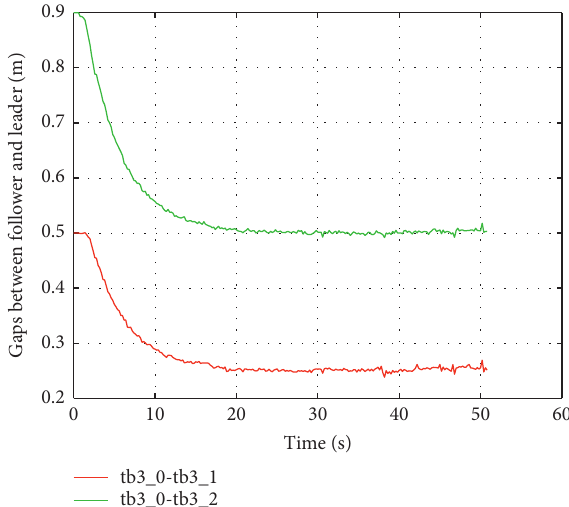
Figure 11: Gaps between followers and leader in the